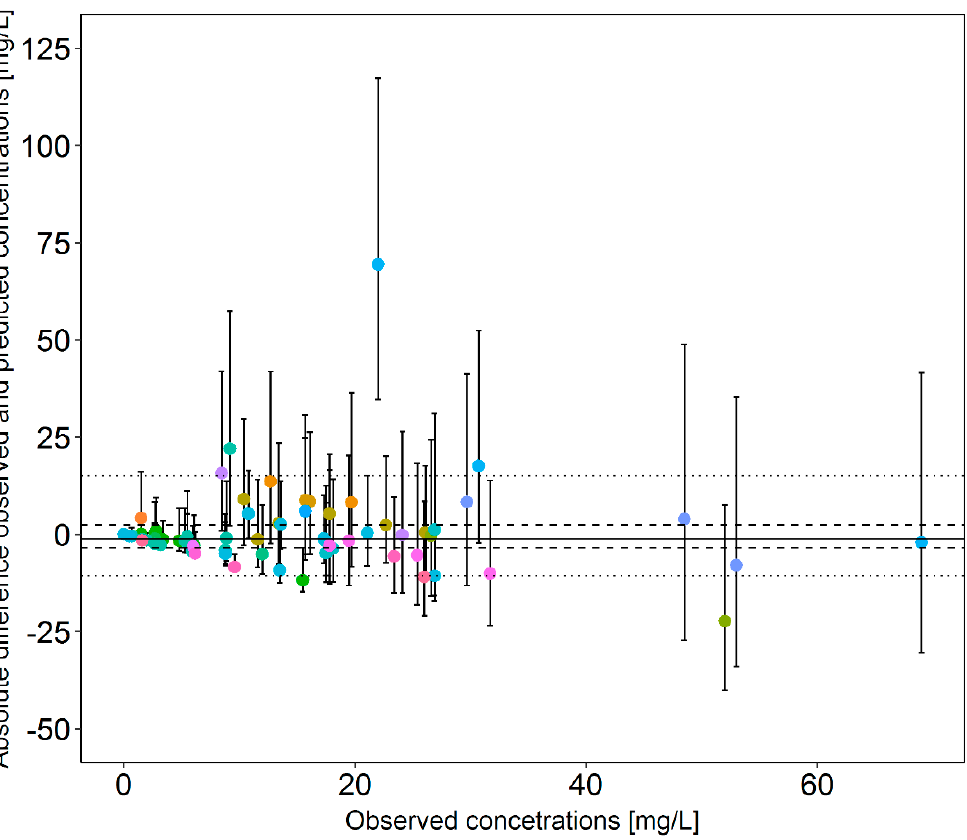
Figure 1. Absolute prediction error (mg/L) plotted against observed meropenem concentrations (n = 66) when predicting concentration based on the reduced pharmacokinetic model for the data in the subset. Points: median prediction error per sample. Colours: individual patients (i = 34). Error bar: 90% prediction interval of prediction error per sample. Solid horizontal line: median prediction error. Dashed line: 50% prediction interval of median prediction error. Dotted line: 90% prediction interval of median prediction error.